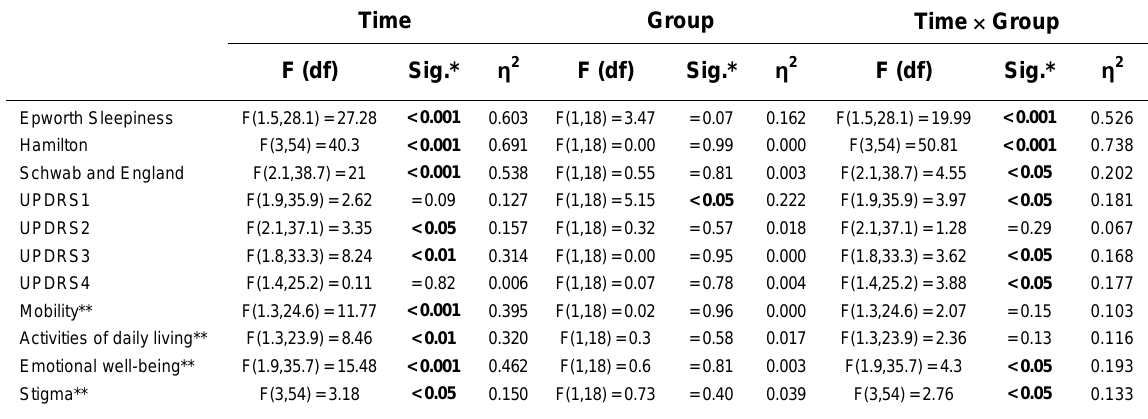
Results of the Doubly Multivariate Repeated-Measures ANOVA with Group (Control, Theater) and Time (T0, T1, T2, T3) as Factors in the Clinical Scales (or Subscales) Time